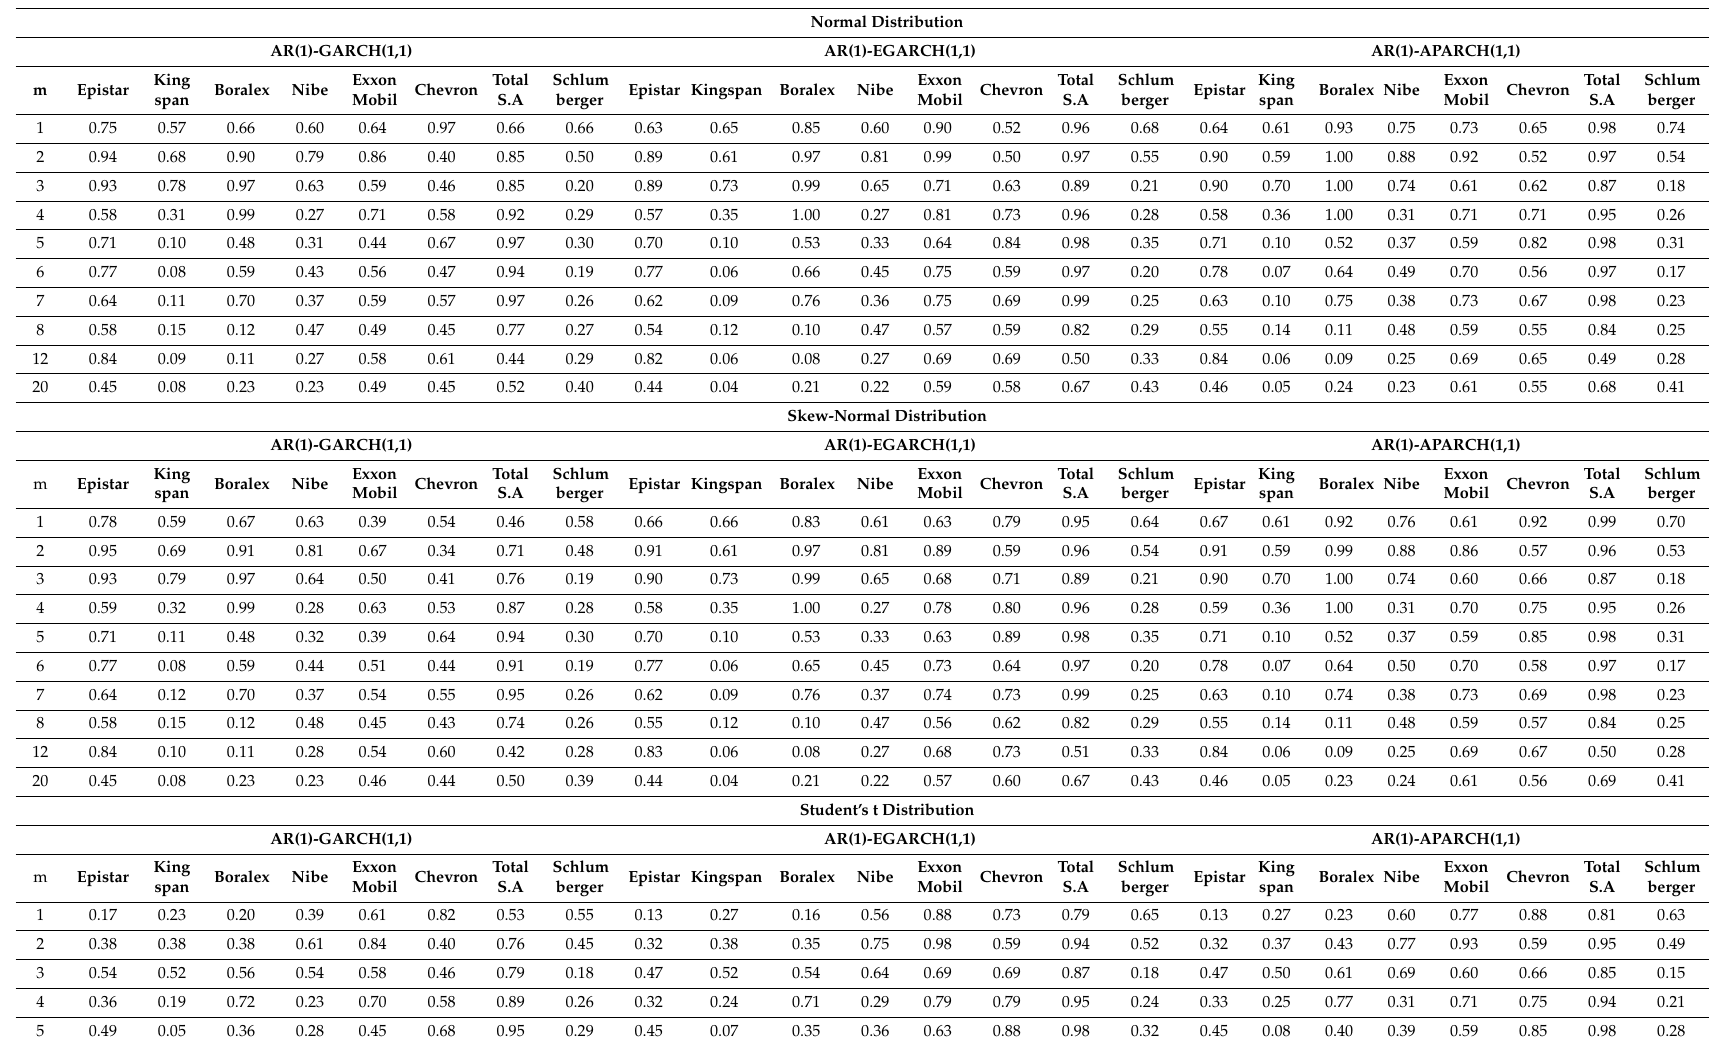
Table A6. Ljung-Box test of standardized residuals from AR(1)-GARCH(1,1), AR(1)-GARCH(1,1) and AR(1)-APARCH(1,1) models. Normal